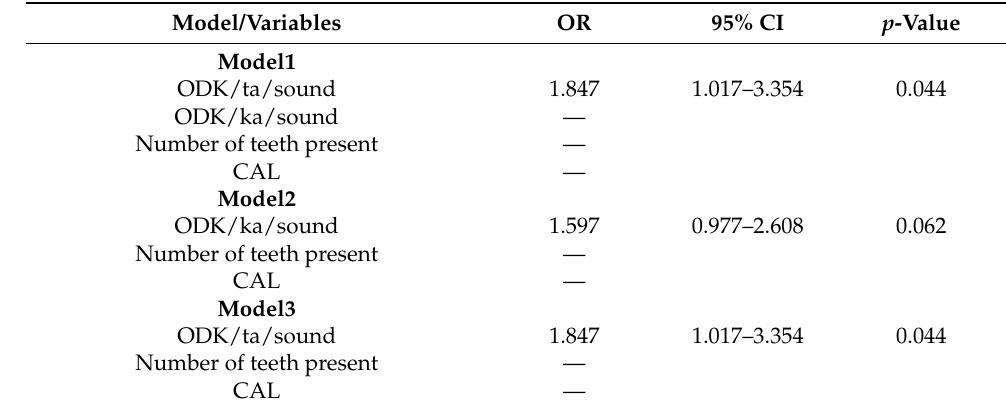
Table 3. Predictors of frailty on stepwise binary logistic regression